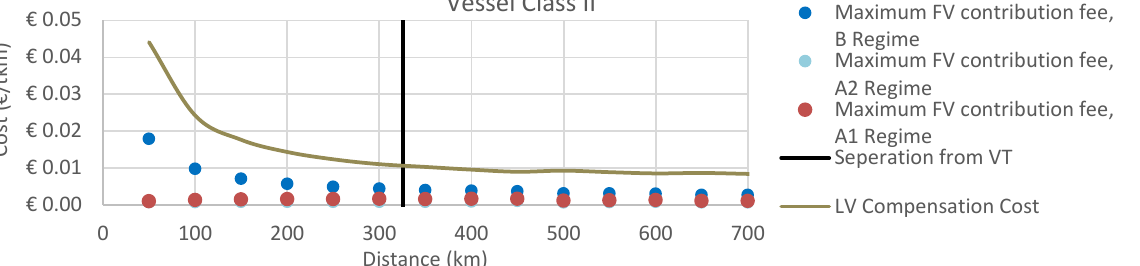
Figure 14: Cost per ton-km Comparison to Reference Vessels and the LV Compensation Cost for Vessel Class II